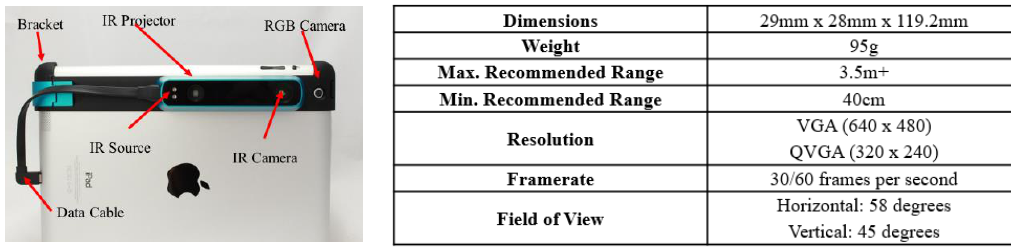
Figure 6. The main elements of hardware used in this paper, which includes one RGB-D camera and one iPad [40]. Table 1. Parameters for system error calibration.